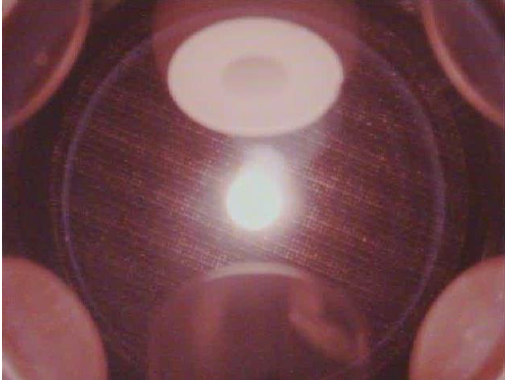
Figure 19. Molten alumina sample levitated in the ISS-ELF.